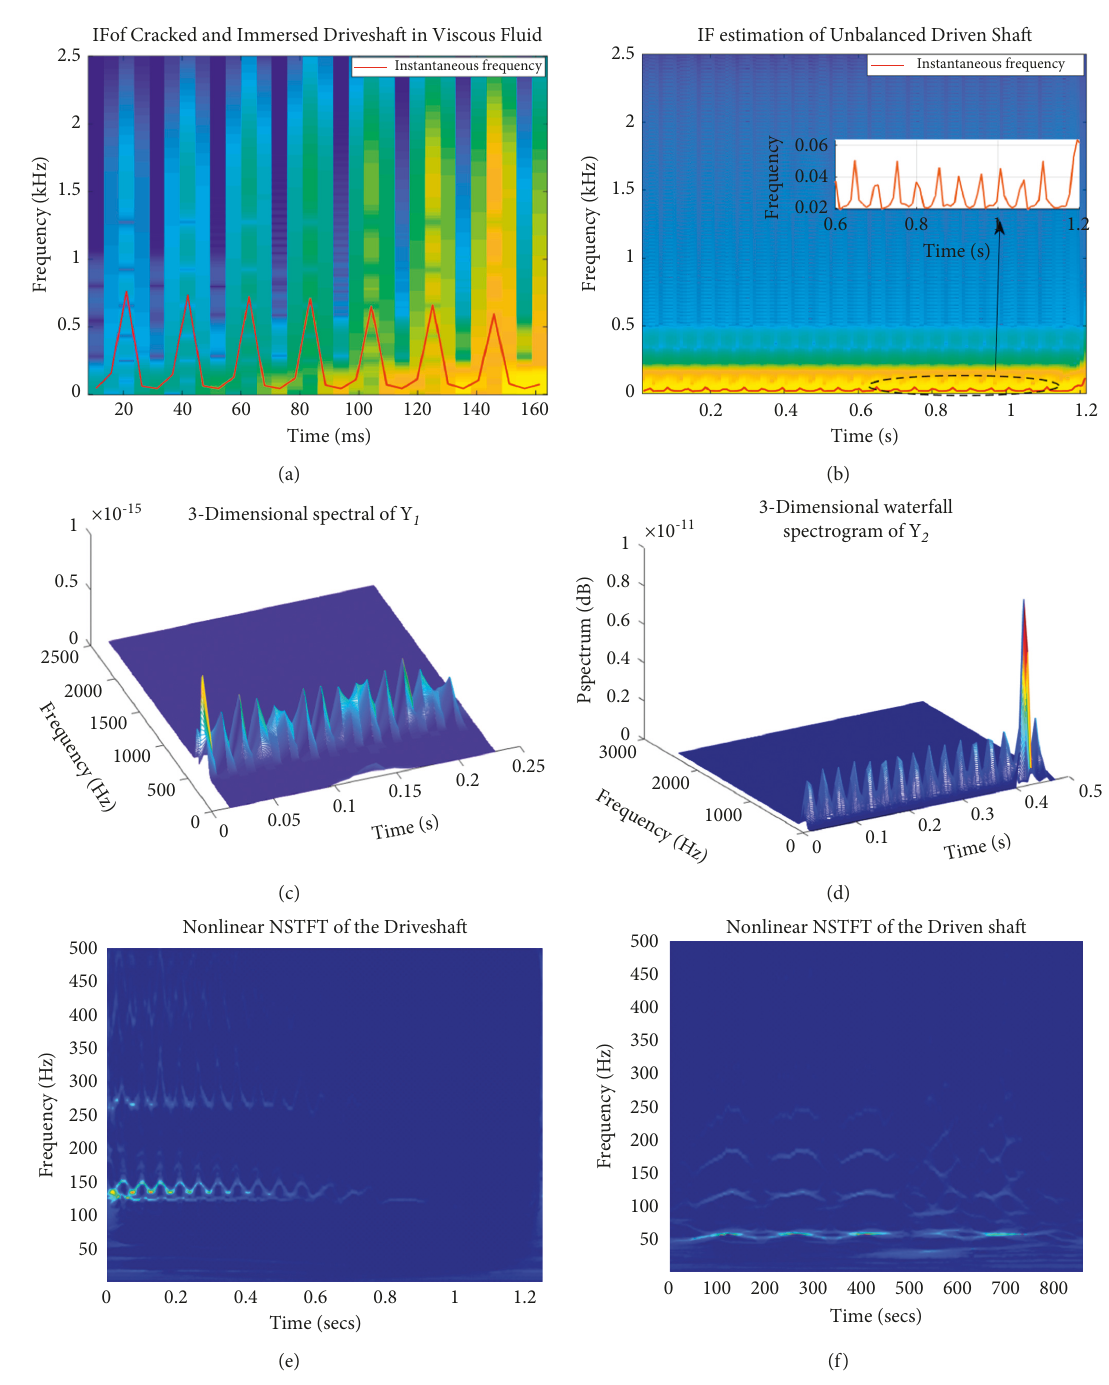
Figure 8: Time-frequency representation of unbalanced and cracked input shaft1 and shaft 2 at 1447.74 rpm. (a) IF of the unbalanced and cracked driveshaft. (b) IF of the unbalanced driven shaft. (c) 3D representation of an unbalanced-cracked driveshaft. (d) 3D corresponding unbalanced driven shaft. (e) NSTFT from synchrosqueezing wavelet. (f) Corresponding NSTFT of the driven